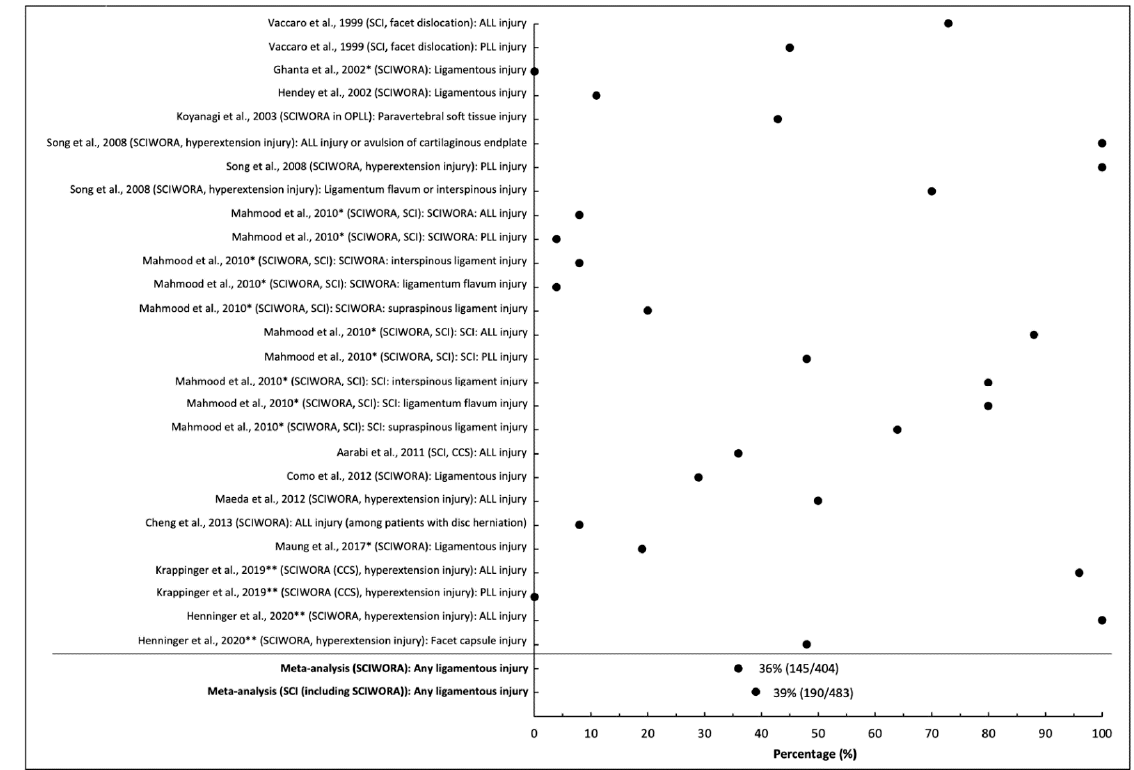
Figure 1. Frequency of ligamentous injury on MRI in patients with acute spinal cord injury. * Studies that include pediatric patients (<16) or unspecified age range. ** Studies with overlapping cohorts.